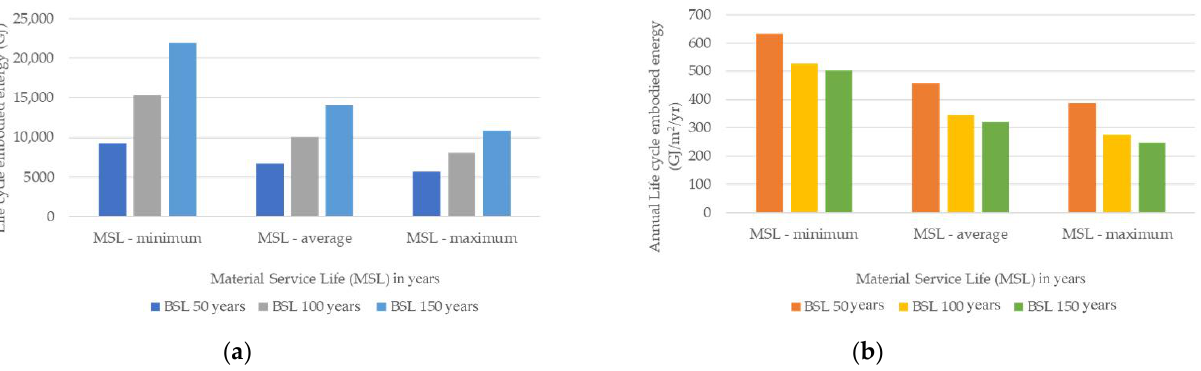
Figure 8. ( a ) Life cycle embodied energy (in GJ). ( b ) Annual life cycle embodied energy (in GJ/m 2 /year) of the case study house with material service life variations for building service lives of 50, 100 and 150 years.